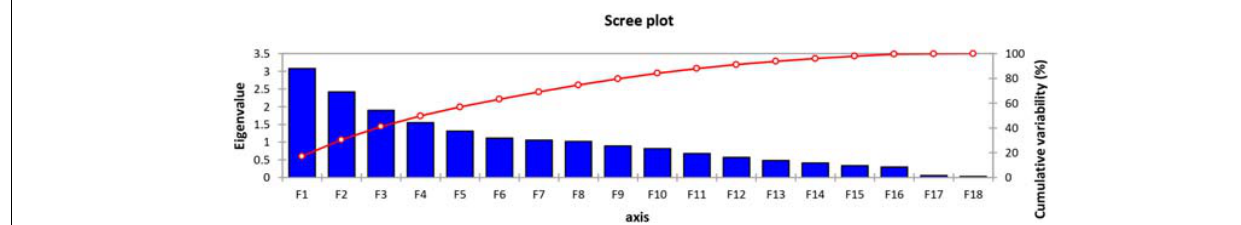
FIGURE 1 | Scree plot representing cumulative variability and Eigenvalues for studied parameters.